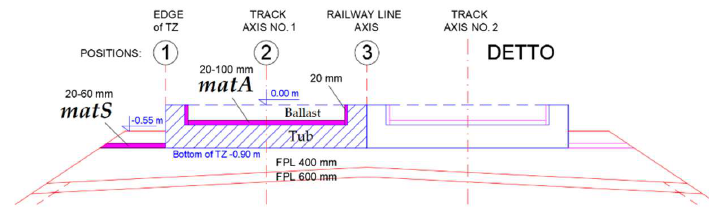
Figure 8. Optimal design of the solution against freezing of the TZ structures.